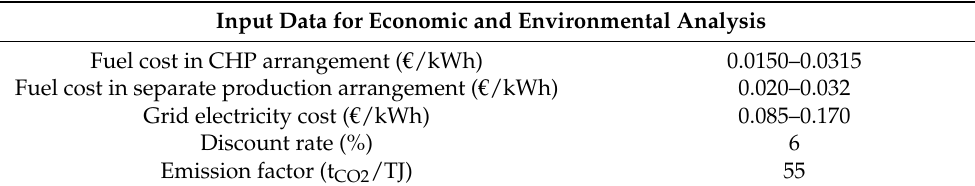
Table 6. Input data for economic analysis (different technologies). Table 5. Input data for economic and environmental analysis common to all technologies.